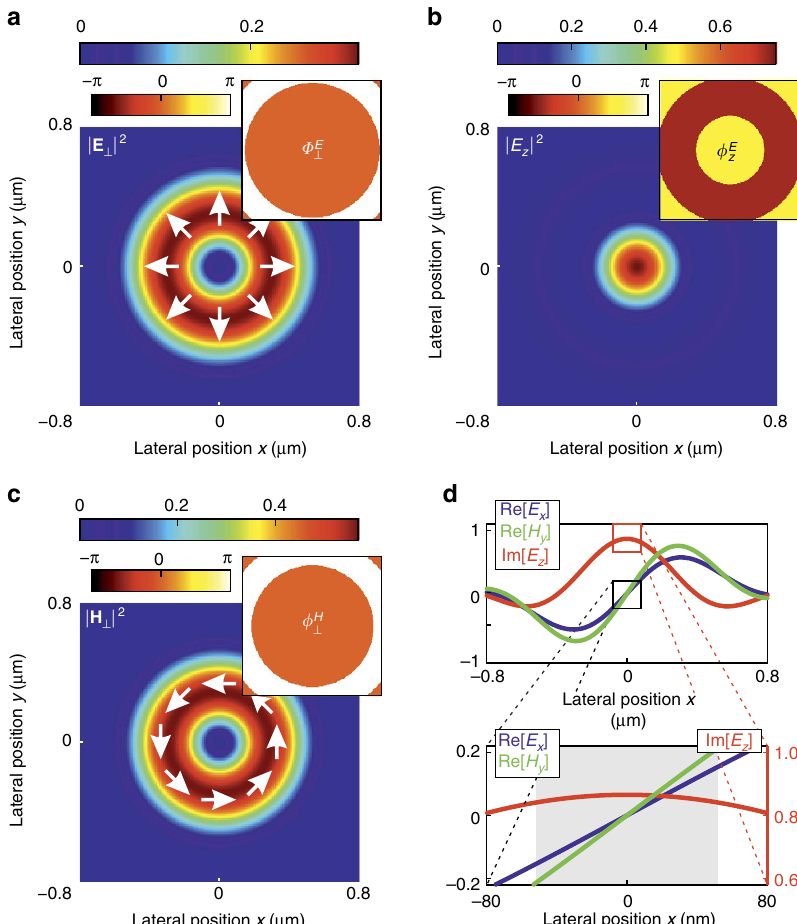
Figure 1 | Theoretical field intensity distributions and relative phases of a tightly focused radially polarized beam. The wavelength l ¼ 652nm and experimental parameters are taken into account (see Methods section). ( a ) The transverse (radial) electric field intensity E ? j j 2 ¼ E x j j 2 þ E y (cid:4) (cid:4) (cid:4) (cid:4) 2 , ( b ) the longitudinal electric field intensity E z j j 2 and ( c ) the transverse (azimuthal) magnetic field H ? j j 2 ¼ H x j j 2 þ H y (cid:4) (cid:4) (cid:4) (cid:4) 2 are all normalized to the maximum value of the total field intensity, I tot ¼ E j j 2 þ H j j 2 (Gaussian units). The corresponding phase distributions f E the focal fields along the x axis. Close to the centre (grey area in the lower image), the transverse field amplitudes Re[ E x ] and Re[ H y ] are linearly dependent on the position, while the longitudinal field Im[ E z ] is approximately